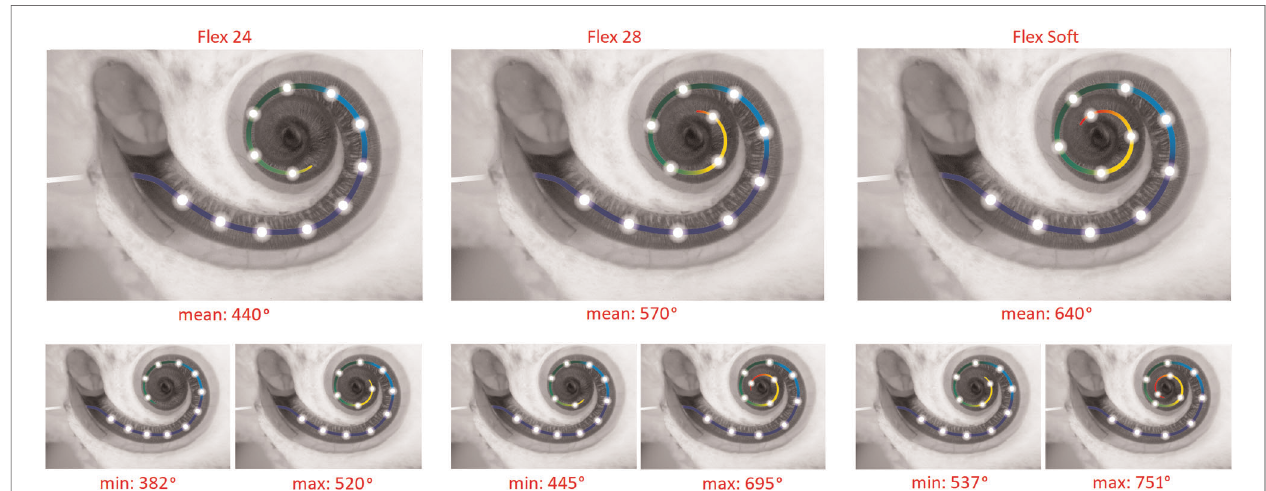
FIGURE 1 | Electrode insertion ranges for Flex 24, Flex 28, and Flex Soft electrodes. To show the true data, only patients with hearing preservation and full insertion were included. The data are from the papers (22 – 27) ( n =163).